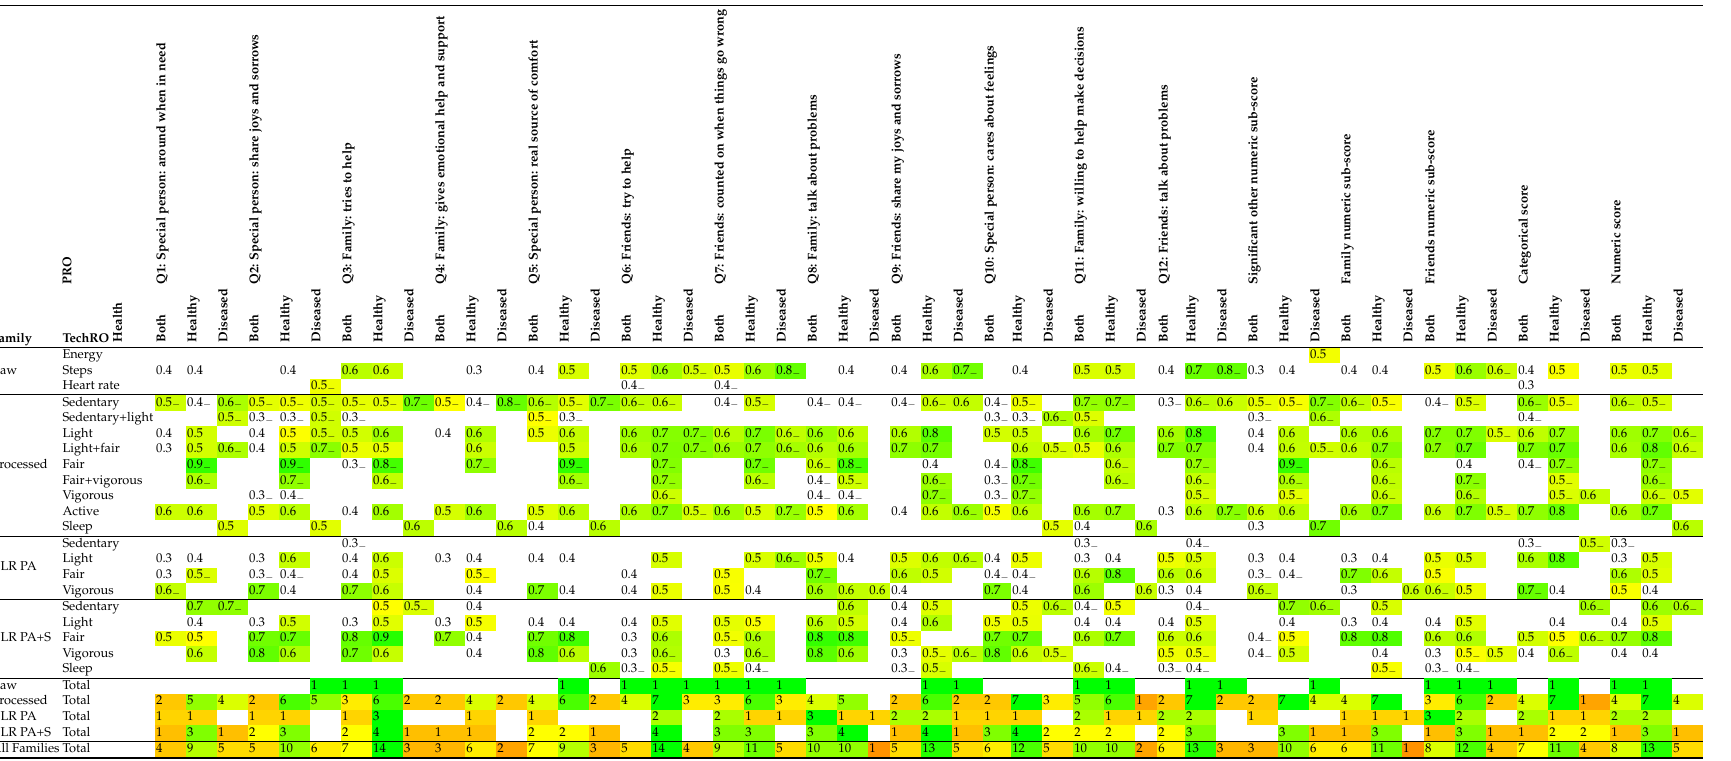
Table A14. Correlation coefficient (Spearman r S ) between TechROs from Fitbit (rows) and PROs of Social Support on the MSPSS scale (columns).